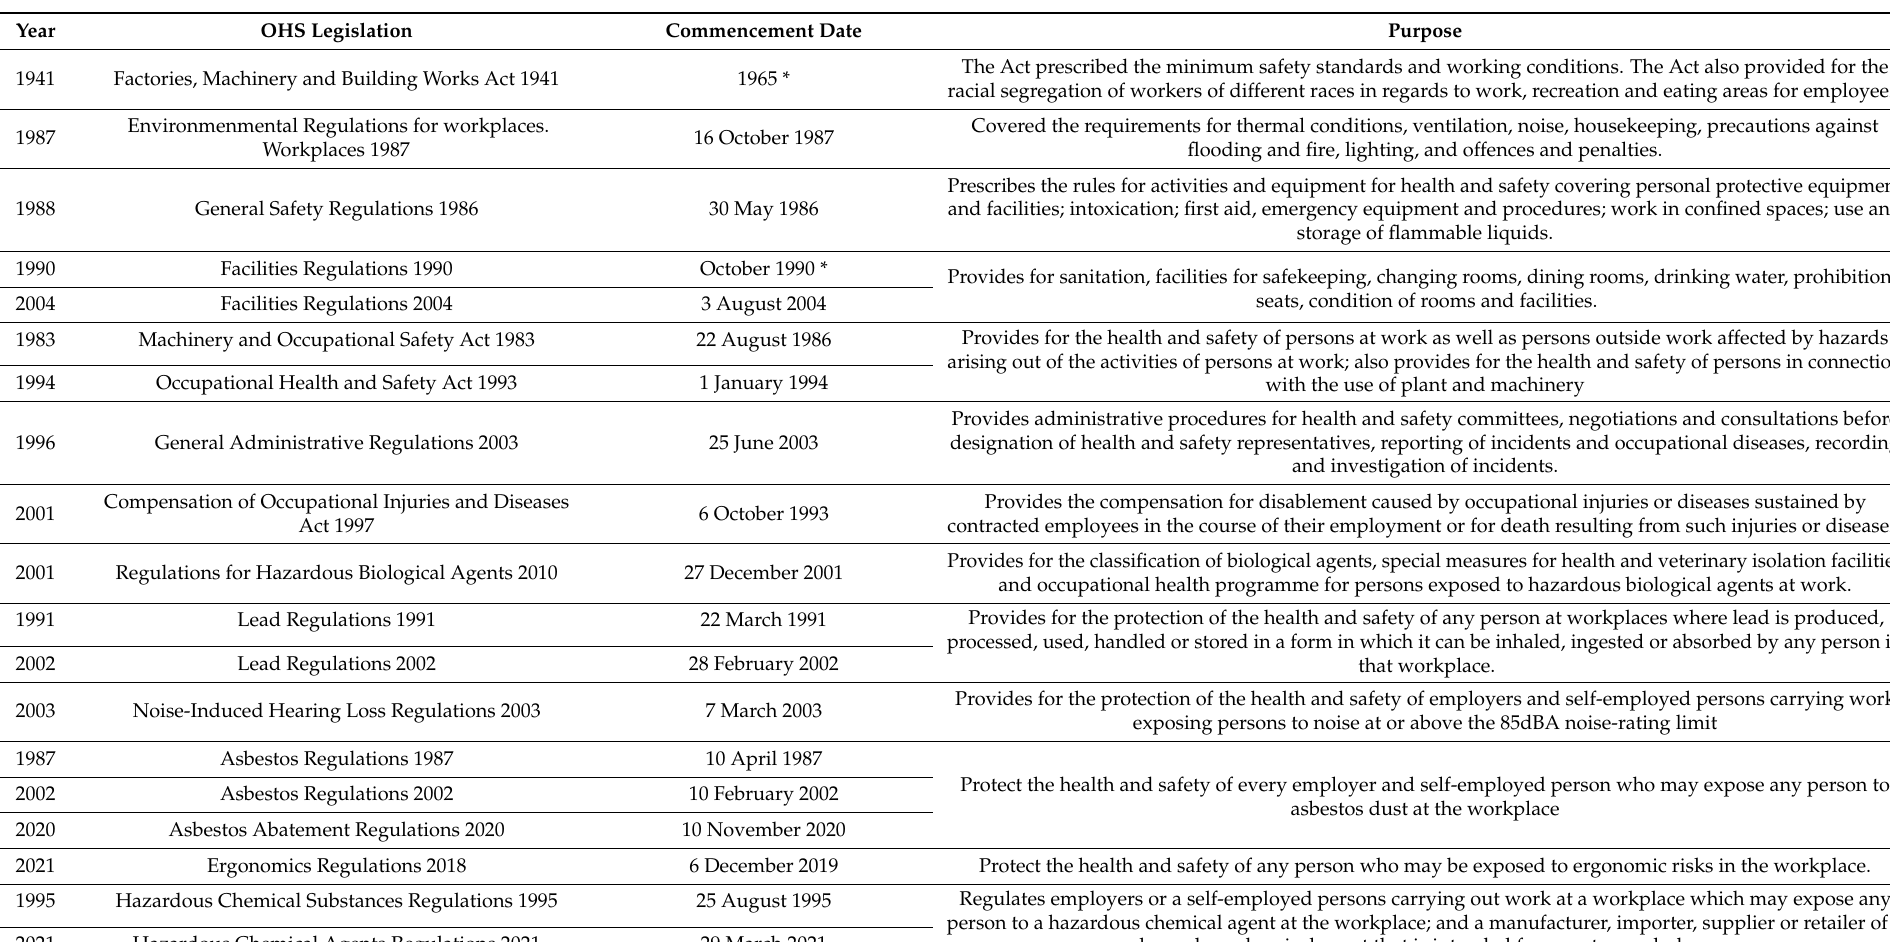
Table A1. Non-exhaustive OHS legislative history from South